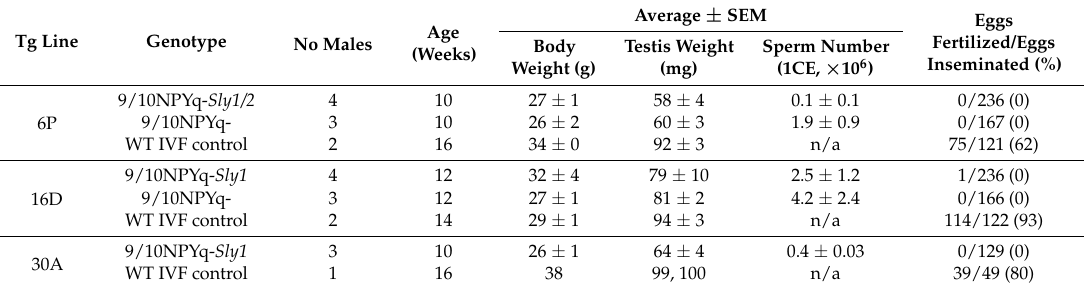
Table 1. Addition of the Flag-Sly transgene to males with severe NPYq deficiency does not rescue low sperm number and sperm ability to fertilize oocytes in